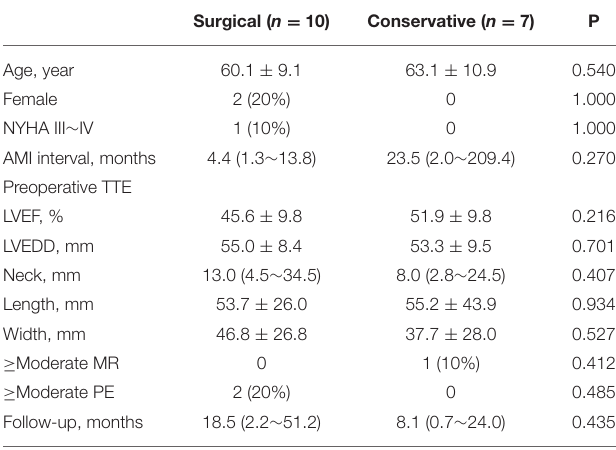
TABLE 2 | Comparison of baseline characteristics between the two groups. Surgical ( n =